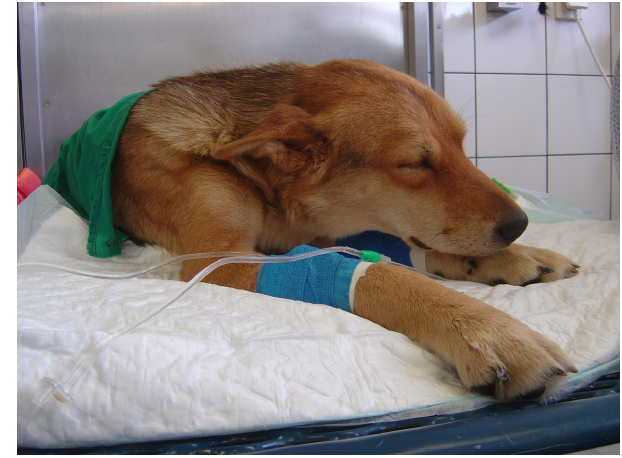
Figure 1. At presentation, the dog was cachectic, sleepy but responsive, sternally or laterally recumbent.